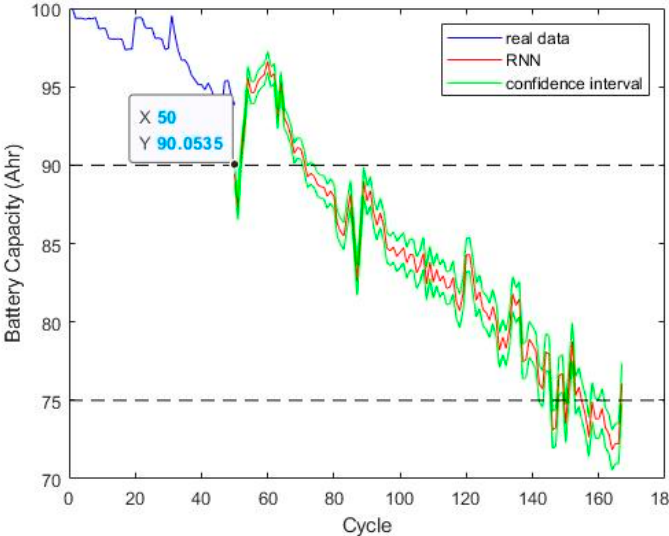
Figure 14. Prediction results of NARX (after 50 cycles).